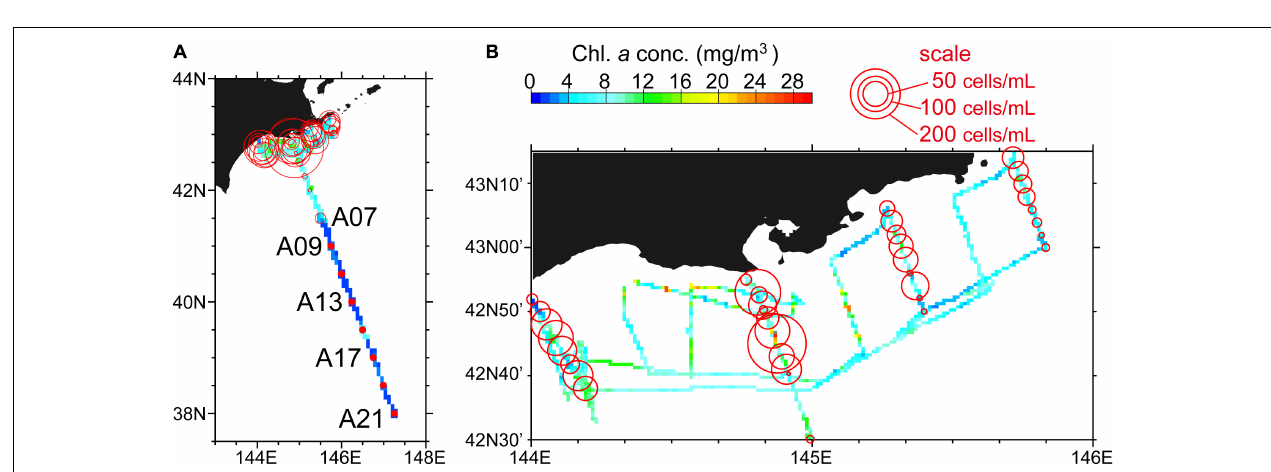
FIGURE 4 | Surface chlorophyll- a concentrations (colored grid cells) along the ship track during 4–14 October, 2021. Grid cells shows averages across (A) 5 (cid:48) (longitude) × 5 (cid:48) (latitude) (i.e., an approximately 7 × 9 km rectangle) and (B) 45 (cid:48)(cid:48) (longitude) × 30 (cid:48)(cid:48) (latitude) (i.e., an approximately 1 × 1 km rectangle). Karenia spp. abundance at a depth of 10 m is also shown by the area of red circles. Red closed circles indicate that Karenia spp. were not found.